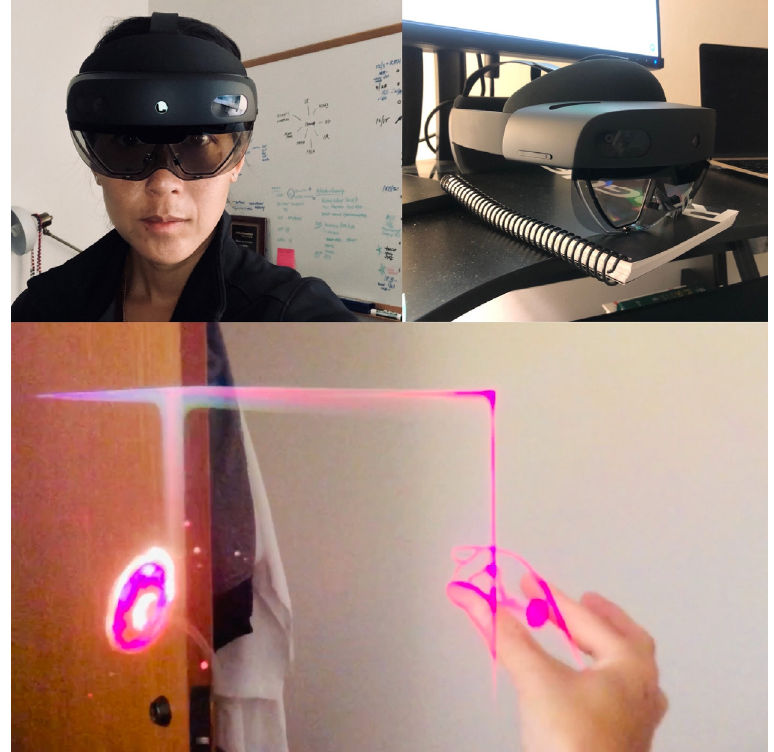
Figure 3. Sample augmented reality headset (hands-free, head-mounted display). User is wearing the device and projected image is displayed in real time in a real environment.